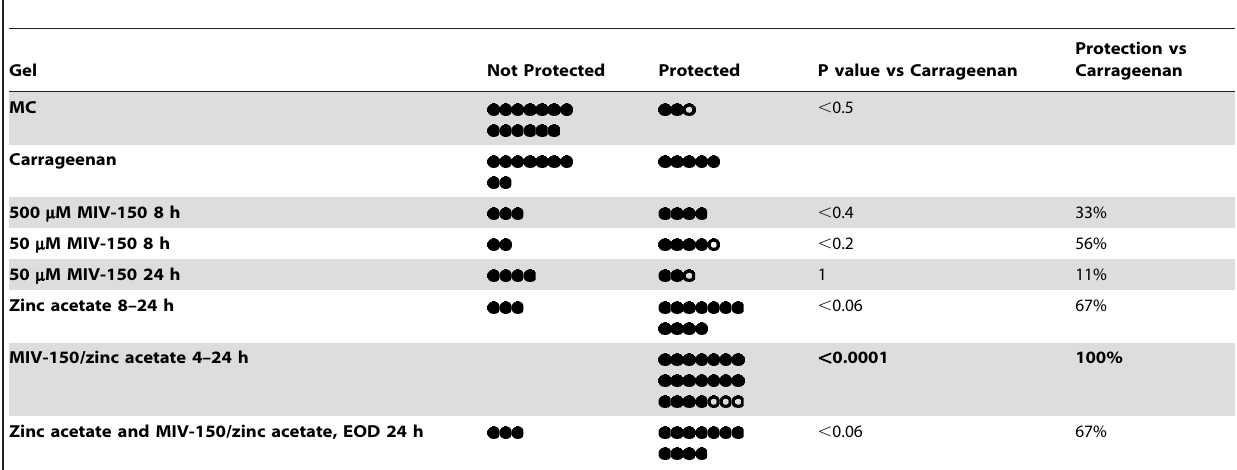
Table 1. A MIV-150/zinc acetate gel provides significant protection against vaginal SHIV-RT infection.